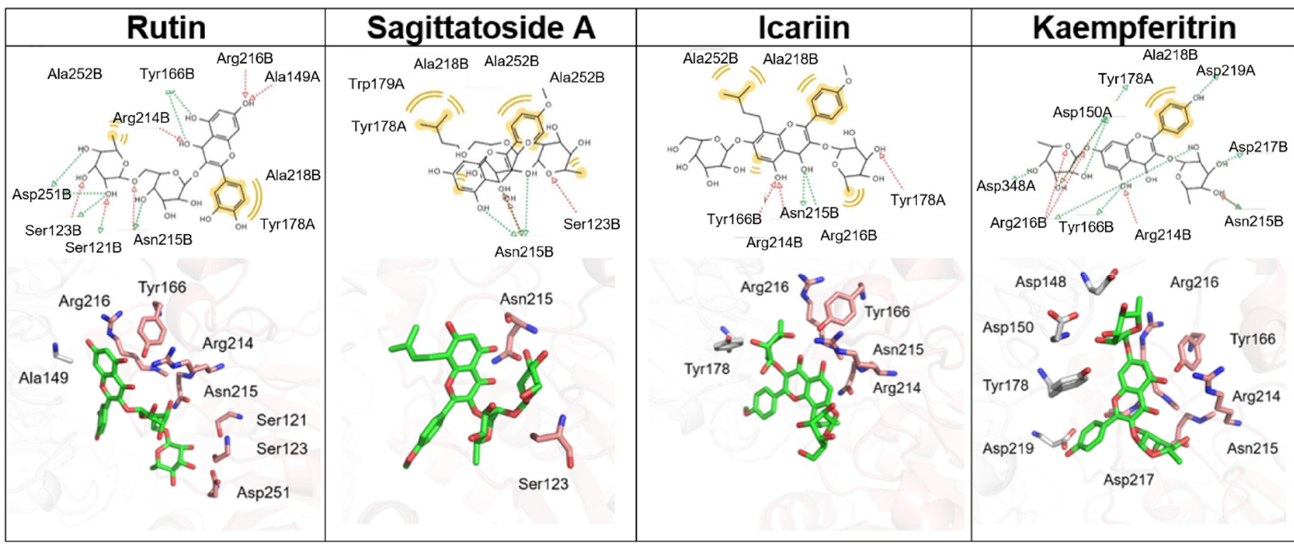
Figure 8. The 2D and 3D binding poses of candidates in a binding site of integrin. Ligands (green) are bound with amino acids in chain A (white) and chain B (pink). The pharmacophore features are represented as green arrows (HBD), red arrows (HBA), and yellow spheres (hydrophobic property).